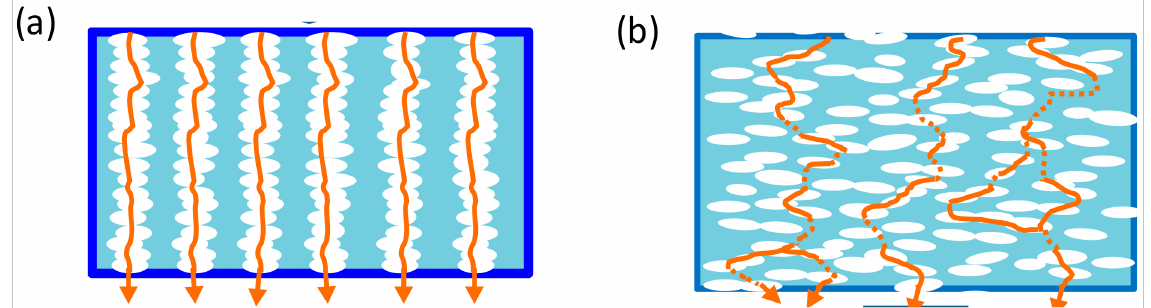
Figure 6. Schematic diagram of the cross-section of separator membrane with ( a ) linear pathways across the membrane surface by the alignment of pores having the tortuosity ~1, and ( b ) randomly arranged pathways with the tortuosity > >1. Reprinted with permission from [33]. Copyright 2018 ACS